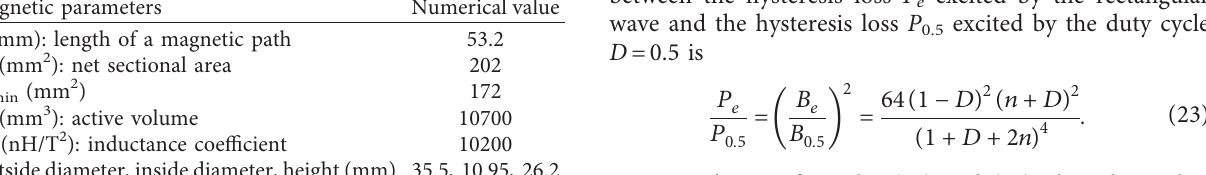
Table 3: Effective parameters of the magnetic core. Magnetic parameters Numerical